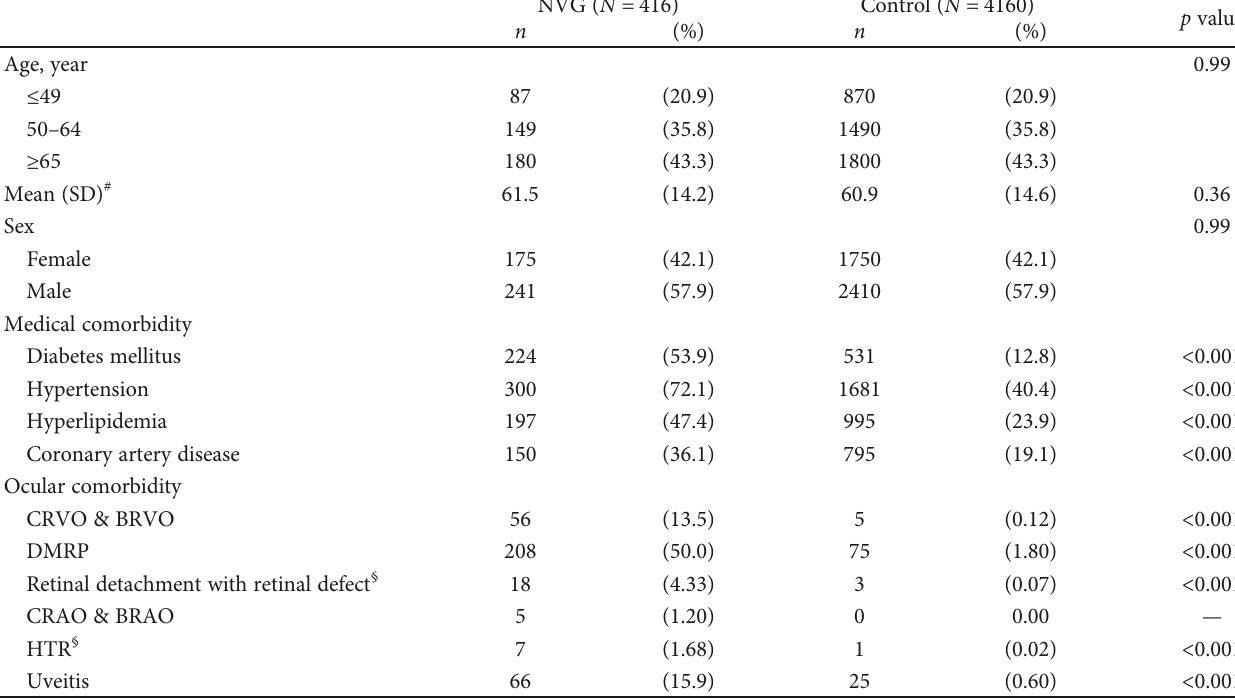
Table 1: Comparison of demographics and comorbidities between patients with NVG and